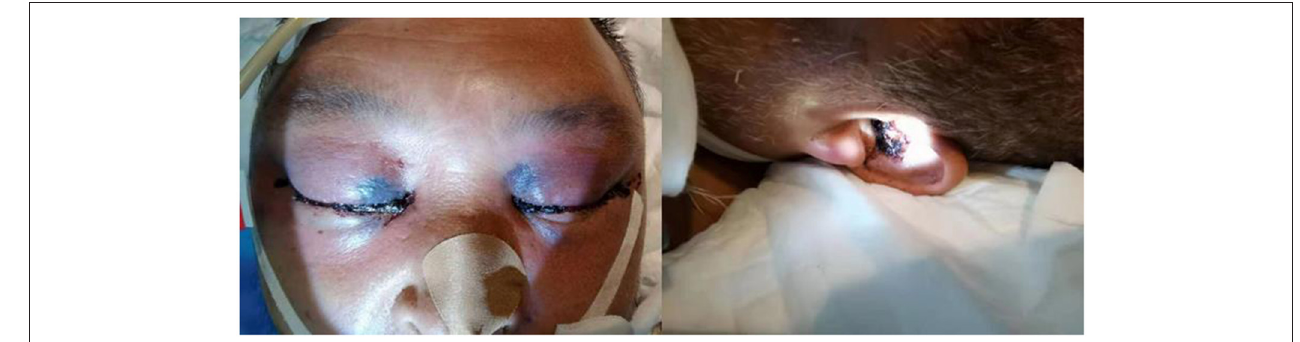
FIGURE 1 | Black eschar lesions of the patient.